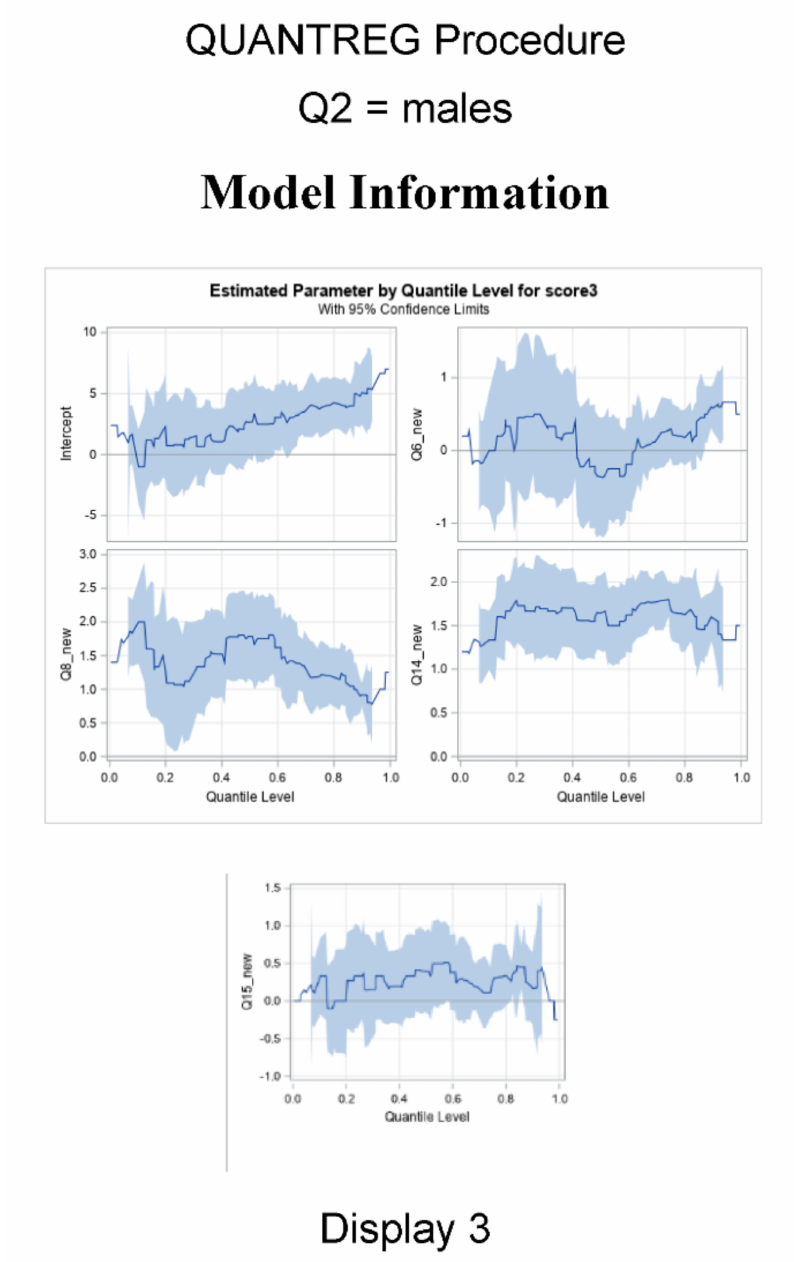
Figure 4. 95% confidence levels for Score 3 with respect to Intercept, Q6_new, Q8_new, Q14_new, and Q15_new for all genders (Display 1), females (Display 2), and males (Display 3). The coefficient progression plots are displayed in Figure 5 at the 10th, 50th, and 90th percentiles. The plots visualize the selection process and show that plans to use science (Q8) and technology (Q19) entered the model first. The plans to use science (Q8) and technology activities (Q19) were predominant, whereas liking to do science activities (Q6), liking to do math (Q12), and the perception of math in science (Q15) were not significant and seemed to intersect. They coincided with the assumption that, when it comes to science, liking and use are contributing factors in STE. In particular, the last result indicates that liking math was not a contributing factor in STE, even though it is significant in the use of STE, which explains